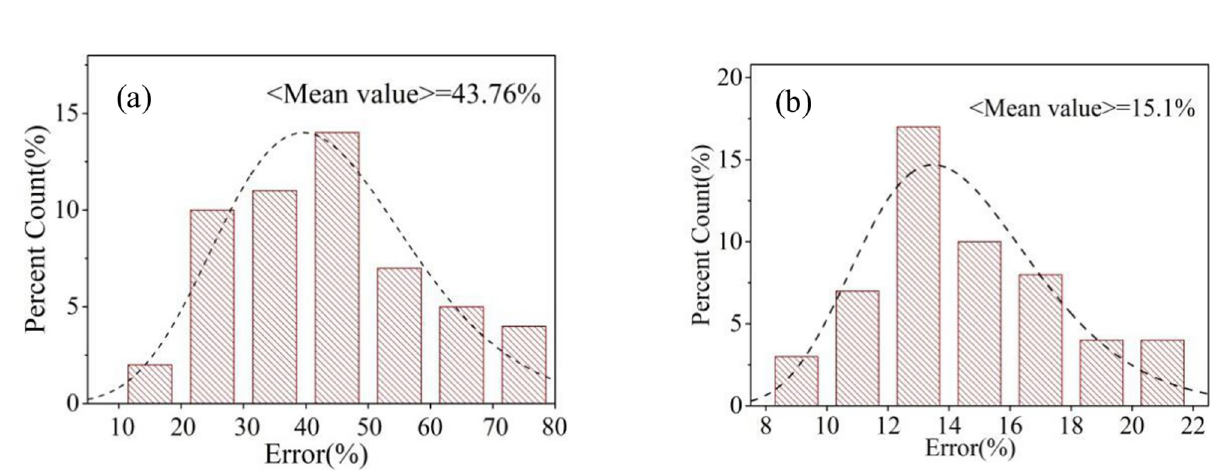
Fig 13. Error distribution of the results based on (a) conventional pollutant emission factor and (b) improved pollutant emission factor.